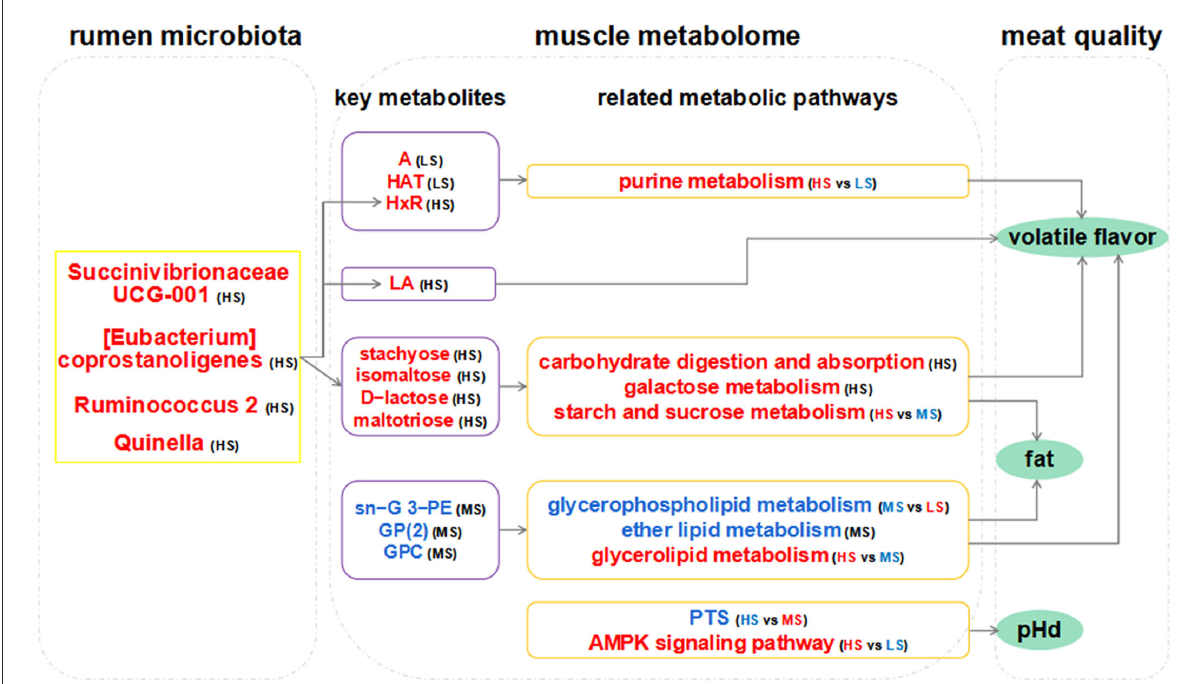
FIGURE7 Hypothesized scheme pathways and potential mechanisms related to the changes in rumen microbiota, muscle metabolome, and meat quality. Metabolites and bacteria in blue and red indicate them downregulated and upregulated significantly in each comparison, respectively. The gray line denotes the regulatory pathways of meat quality. A: adenine; HAT: hypoxanthine; HxR: inosine; PE: phosphoethanolamine; GP(2): glycerophosphate(2); GPC: glycerophosphocholine; LA: linoleic acid; G: glycerol. pHd: the extent of pH decline (within 24h after